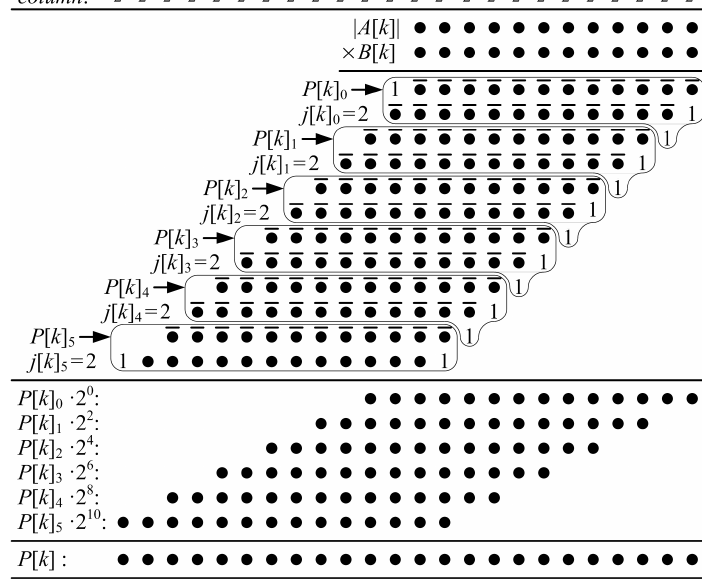
Figure 11. Proposed ( m × n )-bit KCM with eight selectable coefficients, where m = n = 12, A [ k ] is a negative constant and B [ k ] is a signed variable). This example requires approximately 93% more LUTs and three extra stages if pipelined compared to a (12 × 12)-bit KCM with a single